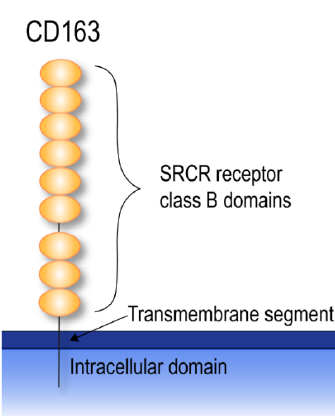
Figure 2. CD163 structure. CD163 is composed of a short intracellular domain, a single transmembrane segment, and an extracellular domain consisting of nine SRCR receptor class B domains. SRCR, scavenger receptor cytokine-rich.